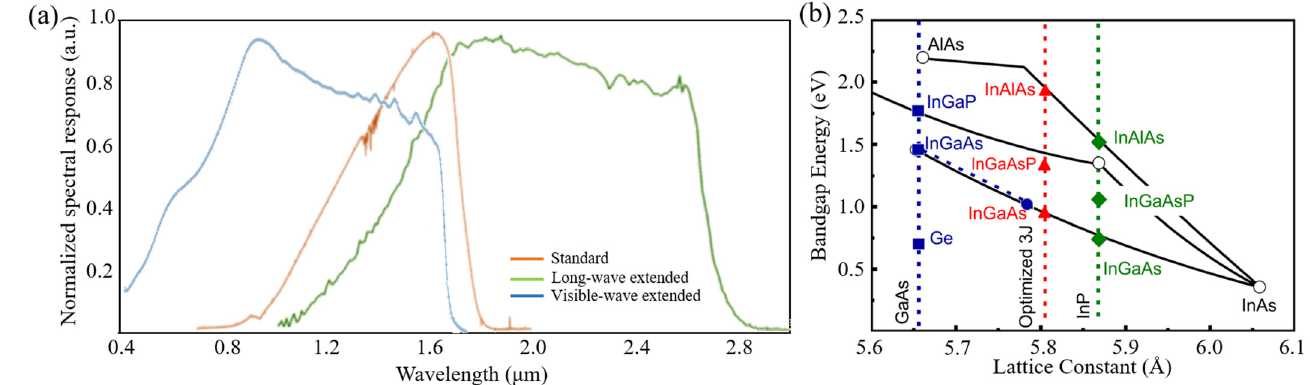
Figure 2. InGaAs PDs. ( a ) The normalized spectral response of standard, long-wave extended and visible extended InGaAs PDs. Date from [7,40,41]. ( b ) Bandgap as a function of lattice constant for III-V binary and ternary compounds. Reproduced with permission from Marina S. Leite et al., Applied Physics Letters; published by AIP, 2013 [42]. Table 1. A summary of InGaAs infrared photodetectors. Date from [44–47]. Structures Institutes